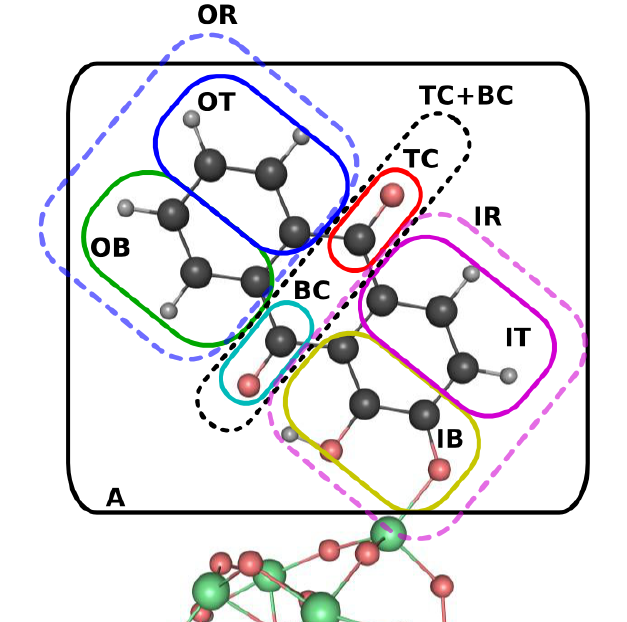
Figure 4. Definition of projectors for the analysis of the electron flux and yield. The boxes define the atoms belonging to a particular fragment, for which a projector is defined using a Voronoi partitioning. The labels OT (IT), OB (IB), and OR (IR) stand for Outer (Inner) Top ring, Bottom ring, and complete Ring, respectively. The carbonyl fragments are labeled TC ( top ) and BC ( bottom ), and the label A refers to the total projector on